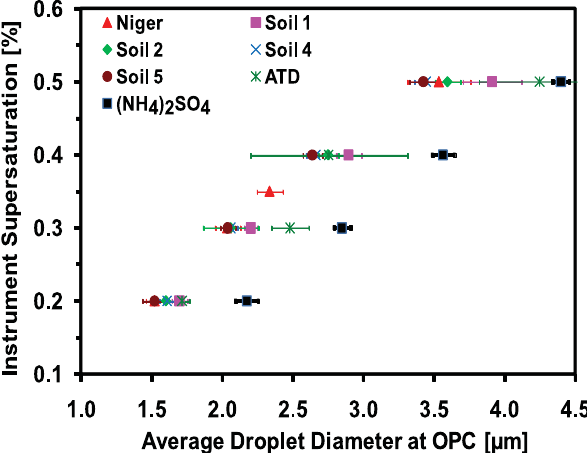
Fig. 9. Activated droplet sizes of different minerals and clay CCN with s c equal to the instrument supersaturation shown as symbols. Error bars represent experimental uncertainty in droplet size as ob- served by the OPC at same instrument supersaturation.